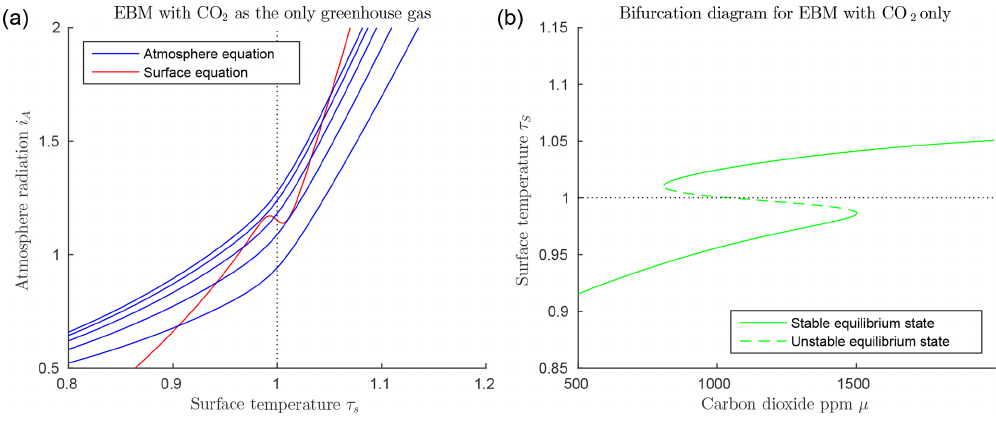
Figure 2. Dry atmosphere EBM Eqs. (22)–(23) (with F A = 65Wm − 2 , F O = 50Wm − 2 , Q = 173 . 2Wm − 2 , α W = 0 . 08 and Z = 9 km). (a) CO 2 values µ = 400, 800, 1200, 1600, 2000; from bottom to top blue curves. A unique cold equilibrium exists for µ = 400 (bottom blue curve), multiple equilibria exist for µ = 800, 1200 and 1600, a unique warm equilibrium exists for µ = 2000 (top blue curve). (b) Bifurcation diagram for the same parameters as in (a) showing the result of solving the EBM for τ S as a function of the forcing parameter µ , holding all other forcing parameters constant. Two saddle-node (or fold) bifurcations occur at approximately µ = 681 and µ = 1881. Three distinct solutions exist between these two values of µ . As µ decreases from right to left in this figure, if the surface temperature starts in the warm state ( τ S > 1), then it abruptly “falls” from the warm state to the frozen state when the left bifurcation point is reached. Similarly, starting on the frozen state ( τ S < 1), if µ increases sufficiently, then the state will jump upward to the warm branch when the right bifurcation point is reached. Both of these transitions are irreversible (one